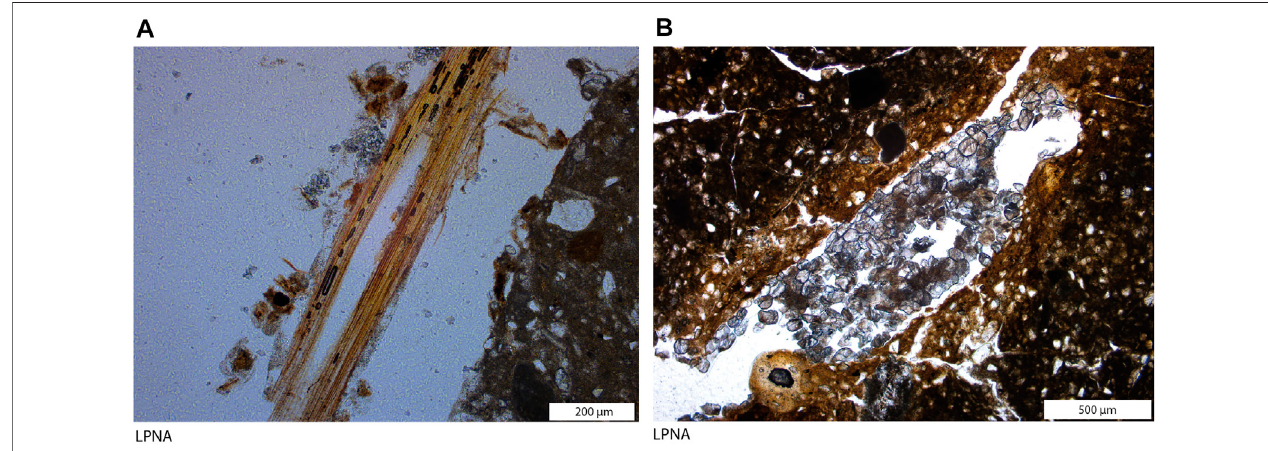
FIGURE 11 | Plant remains including (A) calci fi ed rootlets (sample KH 9H, layer VI) and (B) rootlets, possibly of grasses in the process of decomposition (sample 6H, layer IV).